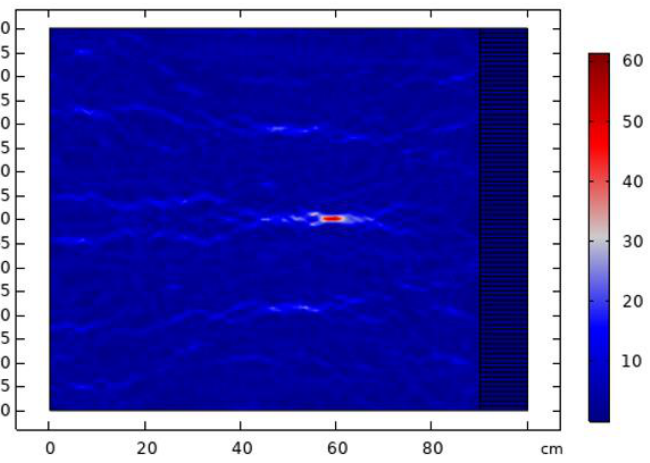
Figure 15. Spatial distribution of acoustic intensity field through focusing lens at 20